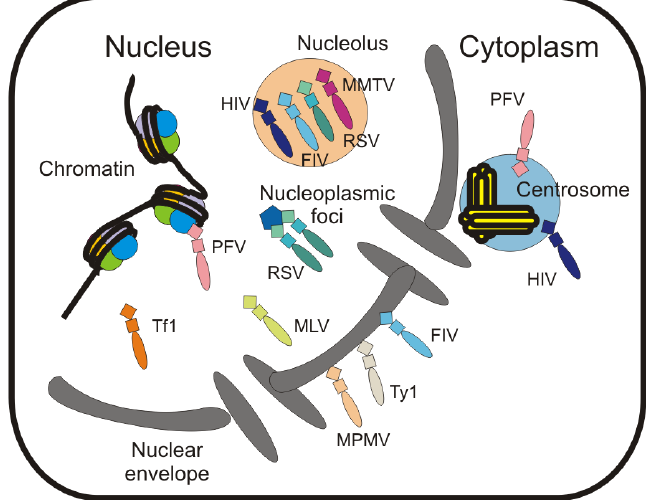
Figure 2. Localization of Gag proteins in and near the nucleus. The Gag proteins of retroviruses and retrotranspons have been detected in the nucleoplasm (MLV, PFV and RSV), in association with chromatin (PFV), in the nucleolus (FIV, HIV-1, MMTV, and RSV), at the nuclear rim (MPMV, Ty1, FIV) and at pericentrosomal sites (HIV-1 and